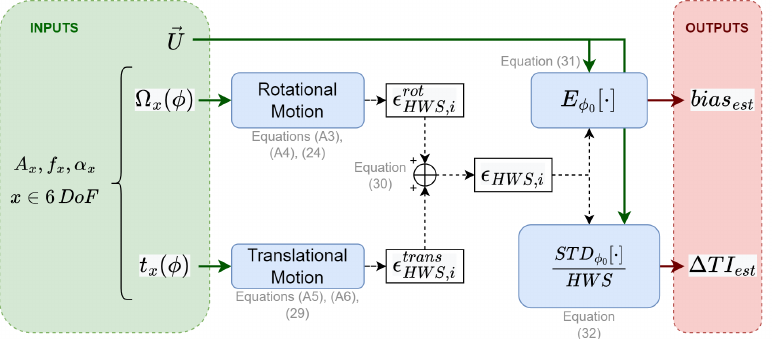
Figure 3. Block diagram depicting the Section 3.5 estimation procedure for the bias and TI